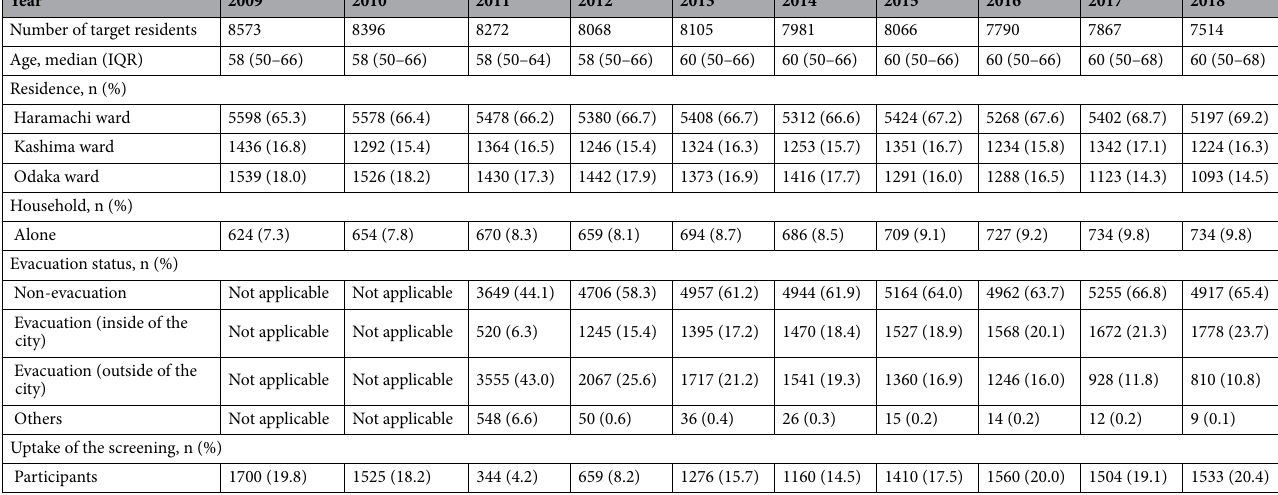
Table 1. Characteristics of the target population for breast cancer screening in Minamisoma City in each year from 2009 to